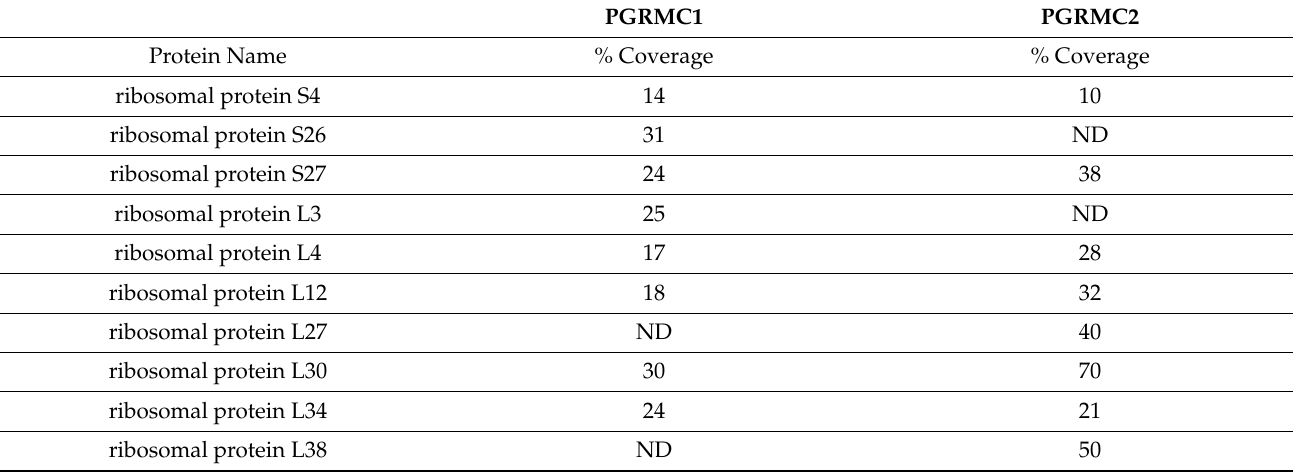
Table 1. Identification of 40s small and 60s large ribosomal proteins that interact with GFP-PGRMC1 and GFP-PGRMC2 fusion proteins in spontaneously immortalized granulosa cells as per previously described protocol [77]. The list of proteins with each protein having at least 10% protein coverage and two or more unique peptides assigned to each protein. ND = not detectable ( ≤ 1 peptide fragment detected). (Peluso unpublished data.)